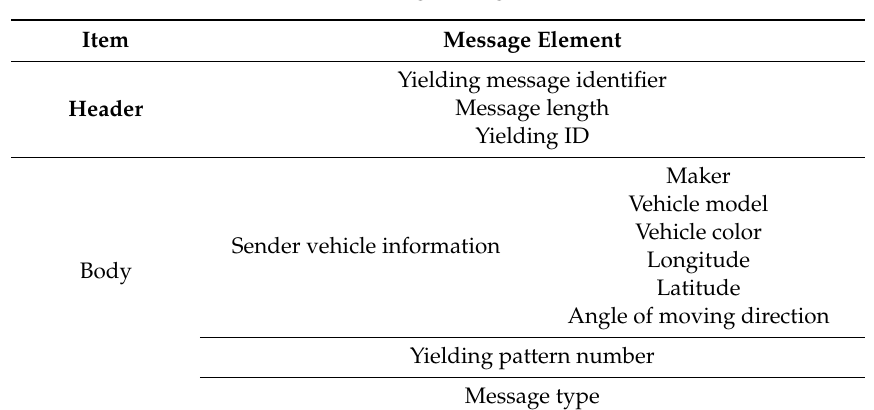
Table 4. Yielding message